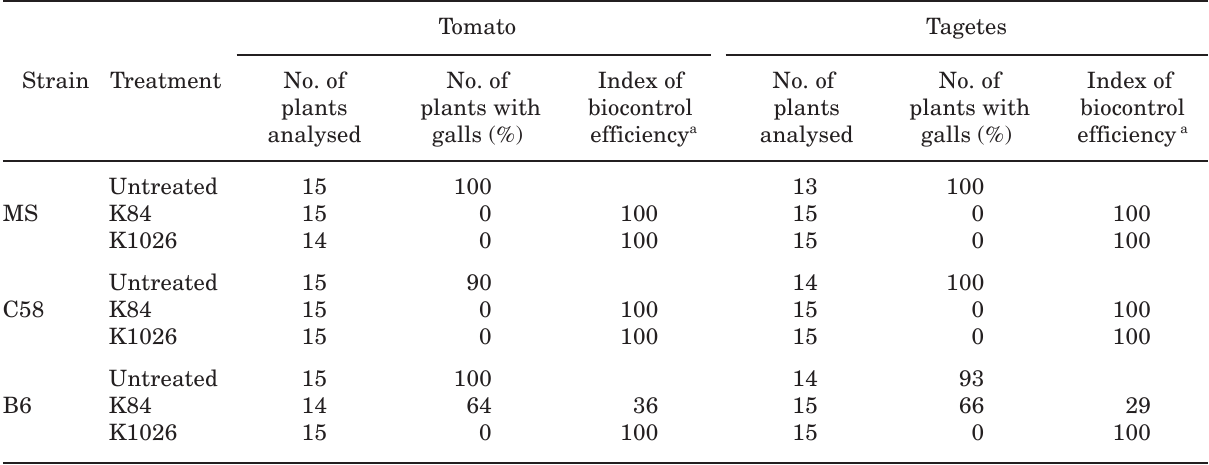
Table 3. Effectiveness of the antagonistic Agrobacterium radiobacter strains K84 and K1026 in preventing tumours on tomato and tagetes